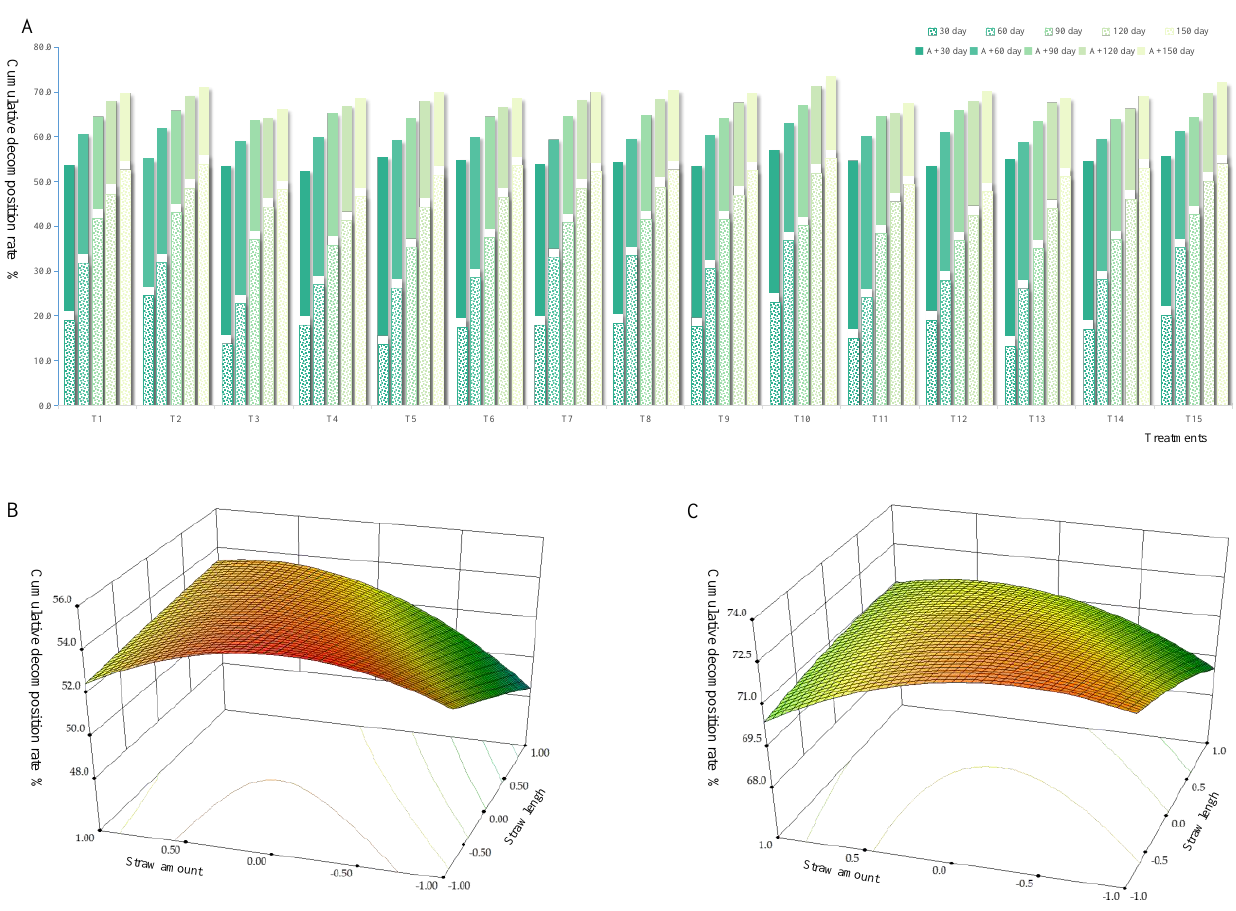
Figure 1. Cumulative decomposition rate of straw with different returning ways. ( A ) Including all straw returning periods; ( B ) after 150 days of straw returning, the change of straw decomposition rate caused by the interaction of straw amount and straw length; ( C ) after (A + 150) days of straw returning, the change of straw decomposition rate caused by the interaction of straw amount and straw length. Notes: The changes of straw decomposition rates caused by the interaction of straw amount and buried depth (Figure S1), and the interaction of straw length and buried depth (Figure S2) are given in Supporting Information.